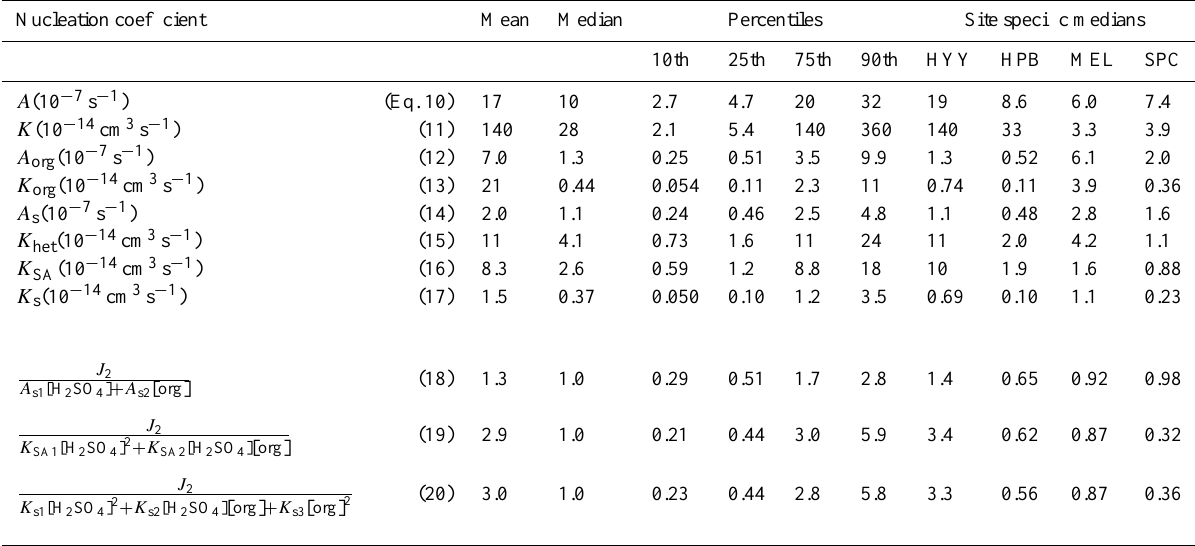
Table 4. Mean, median and percentile (10th, 25th, 75th and 90th) values of the nucleation coefficients for the whole dataset, and median values for separate measurement sites. The mean, median and percentile values of the ratios between the observed and modelled nucleation rates are presented related to the mechanisms including separate nucleation coefficients (the values of which are presented in Table 3). Nucleation